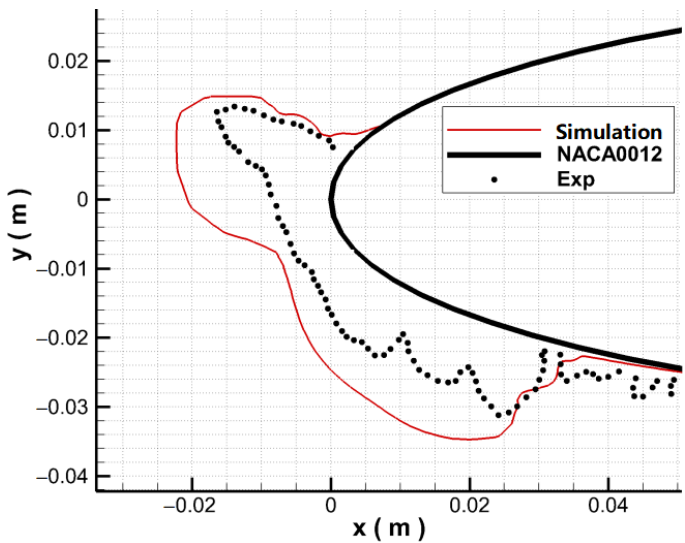
Figure 3. Comparison of ice shapes from the experiment and numerical simulations.